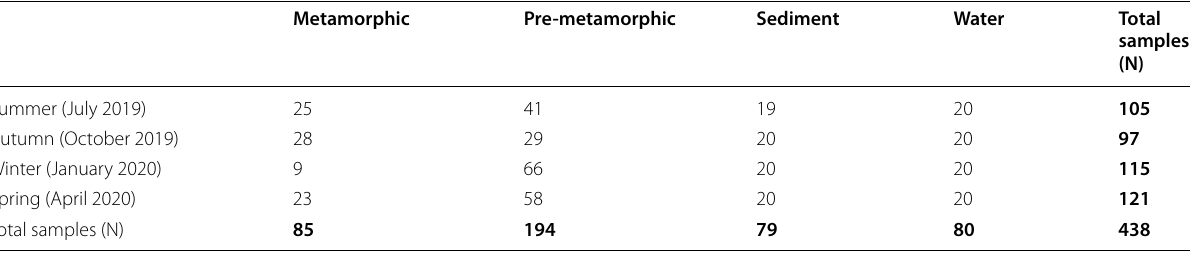
Numbers in bold indicate the total number of samples collected for each sample type or season Number of samples from the skin of A. altamirani individuals (metamorphic and pre‑metamorphic) and environmental samples (sediment and